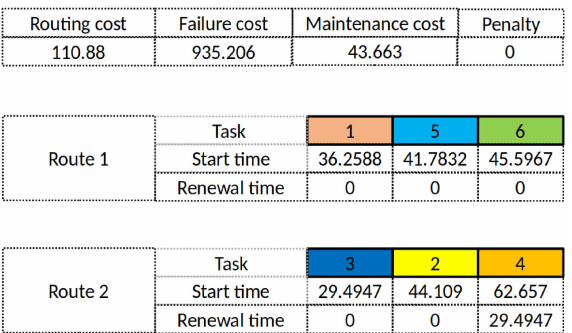
Figure 2. Solution representation of the result minimizing the routing cost for the instance Re/6/2/80/80/0.07/2 (time in